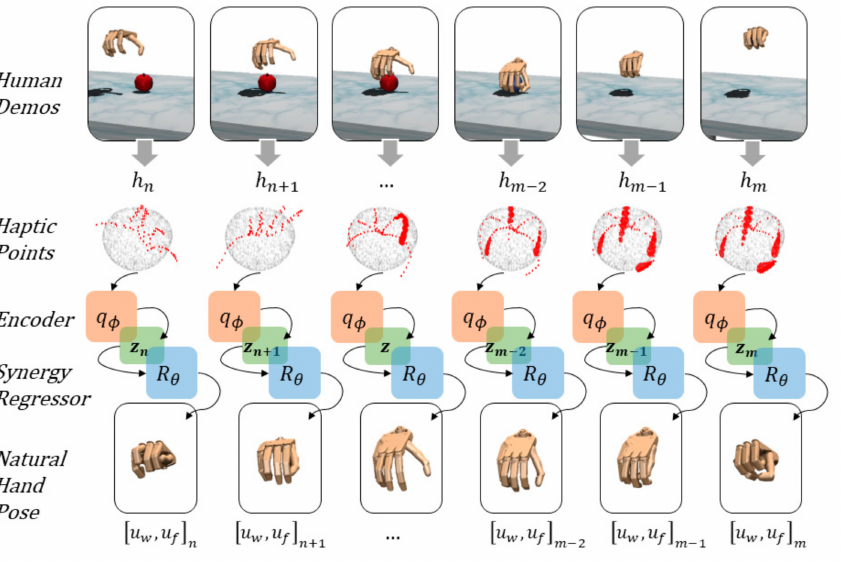
Figure 2. From human demonstrations (top row), haptic information is shown in point clouds (second row). CNF encodes the haptic information, q φ into a synergy space representation, ‡. The deep regressor, R θ ( ‡ ) estimates natural hand poses (final row) in time